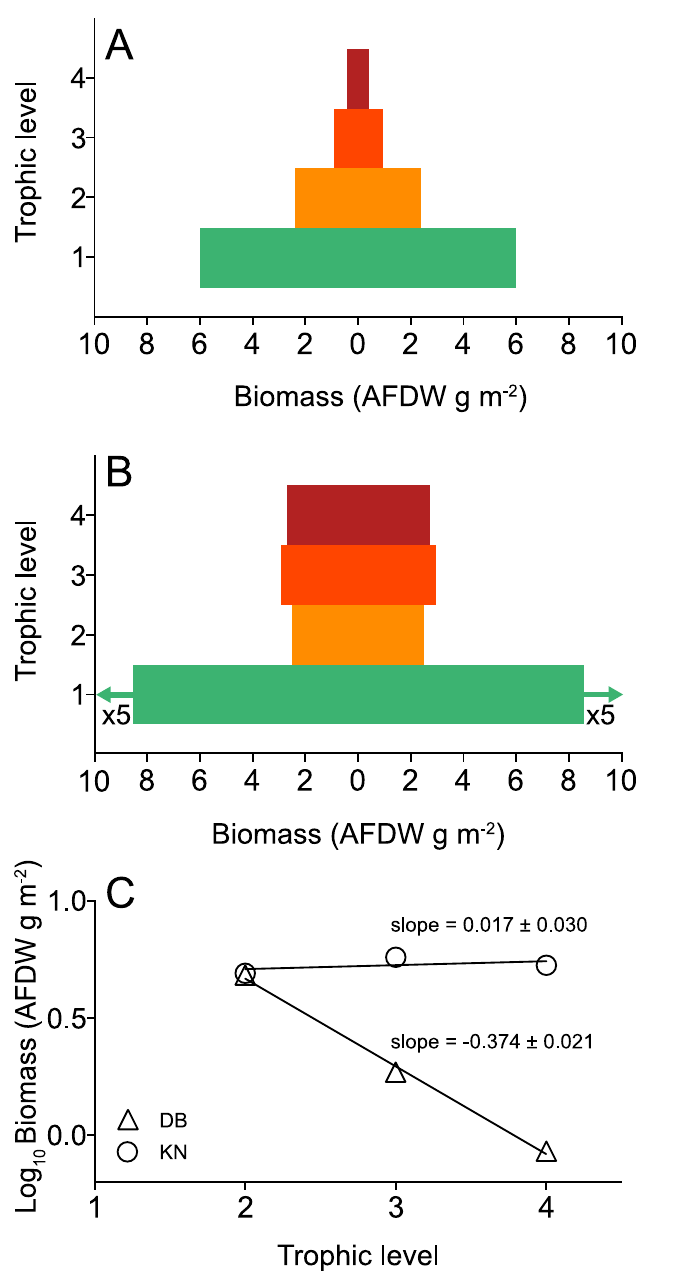
Fig 6. Biomass distribution at trophic levels of Zostera marina meadows in Dalby Bay and Kertinge Nor, Denmark, June 2011. The biomass of each species is distributed across trophic levels (TL) 1 – 4 according to their diet, based on stable isotope mixing model results (Tables 5 and 6), gut contents (S3 Table), and literature data (S4 Table). Combined width of bars indicate biomass at each TL in (A) Dalby Bay and (B) Kertinge Nor. Note biomass value of TL1 in KN is divided by 5 for visual purposes. (C) Linear regression of TL 2 – 4 and log 10 biomass (DB: log 10 biomass = 1.416 – 0.374×TL, R 2 = 0.99; KN: log 10 biomass = 0.683 + 0.017×TL, R 2 = 0.24), with slope indicating overall shape of the consumer part of biomass pyramids in Fig 6A and 6B